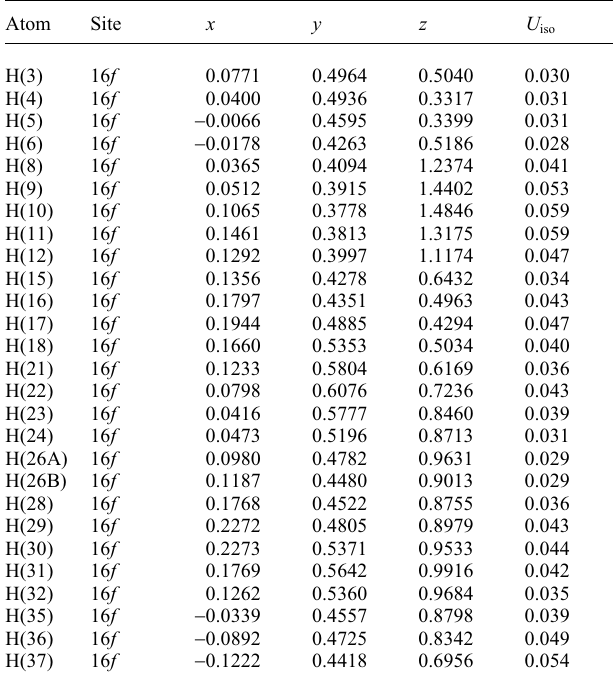
Table 1. Data collection and handling.